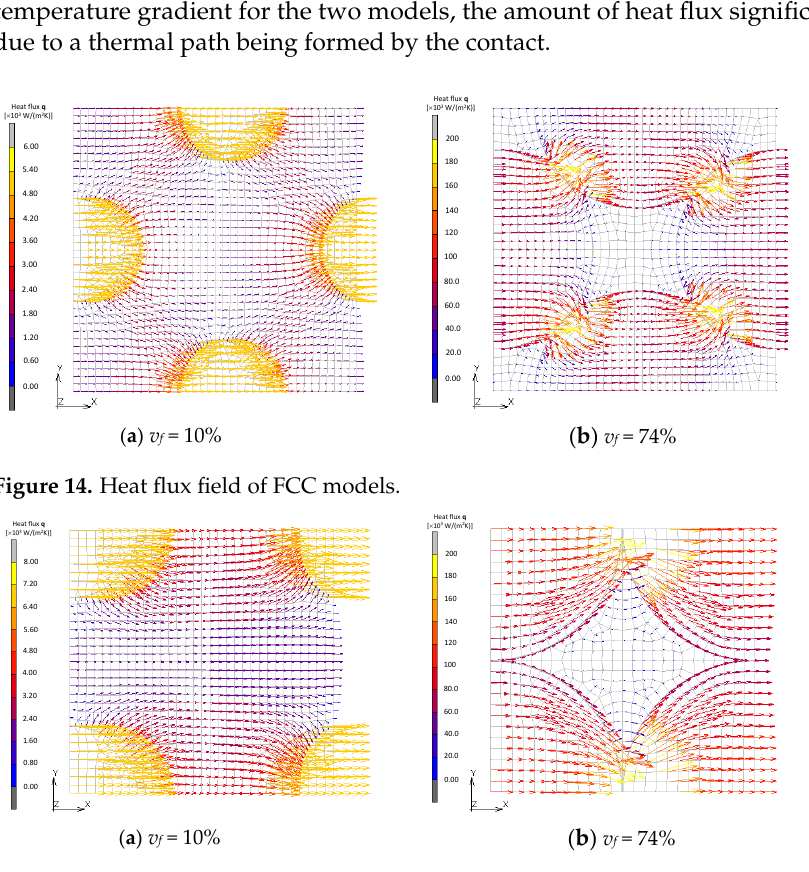
Figure 13. Temperature distribution of Wigner–Seitz cell models.